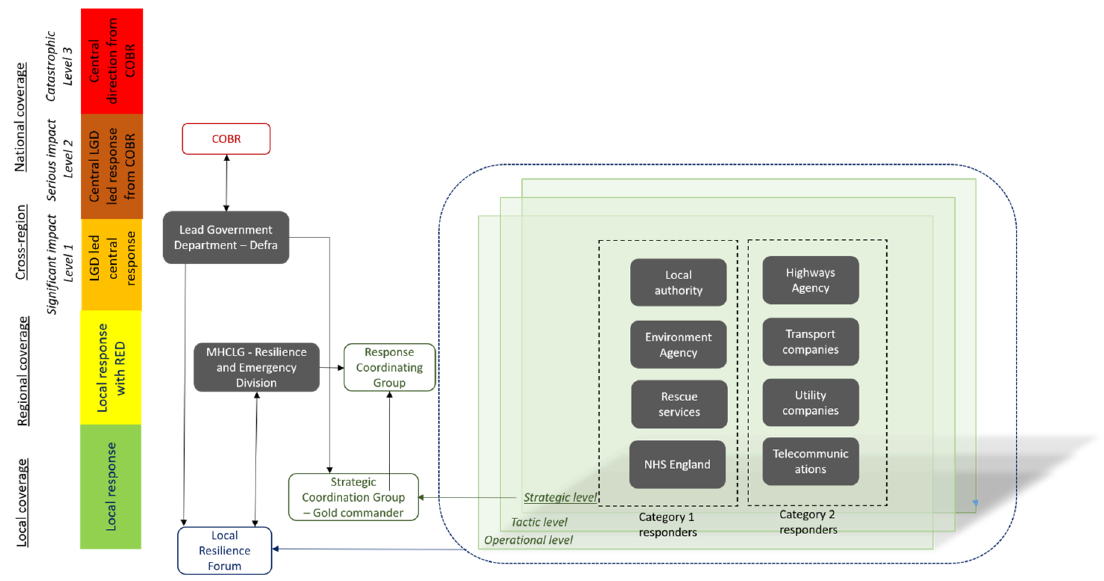
Figure 2. Schematic diagram of flood emergency response in England showing the main agencies and groups involved, the levels of emergency responses at the local level (operational, tactical, strategic), the categories of responding organizations (Category 1 and Category 2) and the likely government arrangements (from local response to central direction from COBR) which depends upon flood extent (local, regional, cross-region and national). Category 1 comprises the organizations that are at the core of the response to most emergencies, whereas Category 2 responders are co-operating bodies involved in incidents that affect their sector. The color schemes in the government arrangements reflect the increasing levels of emergency response (from green to red). COBR: Cabinet Office Briefing Rooms, Defra: Department for Environment, Food and Rural Affairs, MHCLG: Ministry of Housing, Communities and Local Government, RED: Resilience and Emergency Division, and LGD: Lead Government Department.